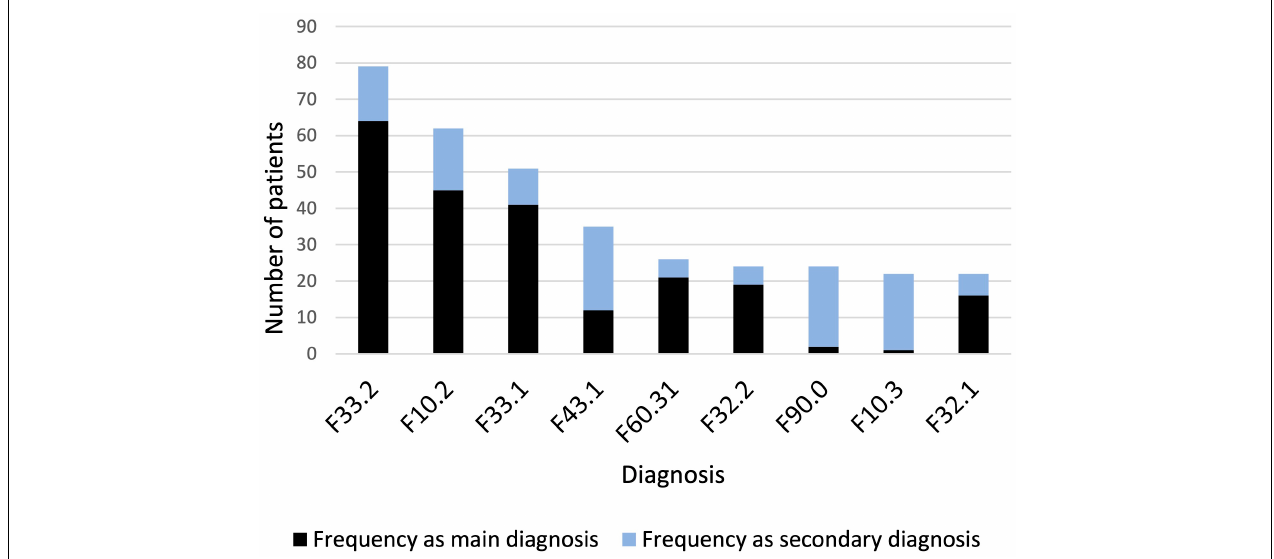
FIGURE 1 | Diagnoses with a cumulative frequency > 20. F33.2: Recurrent depressive disorder, current episode severe without psychotic symptoms; F10.2: Mental and behavioral disorders due to use of alcohol, dependence syndrome; F33.1: Recurrent depressive disorder, current episode moderate without psychotic symptoms; F43.1: Posttraumatic stress disorder; F60.31: Emotionally unstable personality disorder, borderline; F32.2: Severe depressive episode; F90.0: Attention deficit/hyperactivity disorder; F10.3: Mental and behavioral disorders due to use of alcohol, withdrawal state; F32.1: Moderate depressive